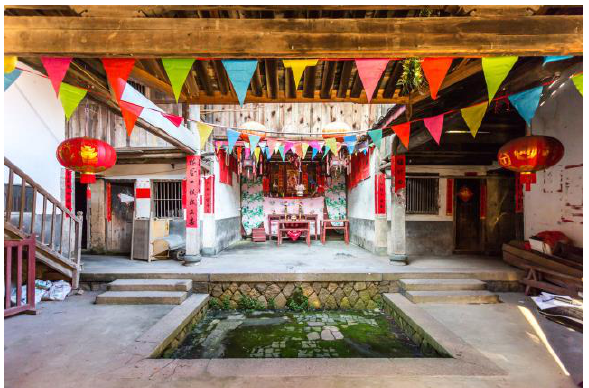
Figure 11. The impluvium and the skywell in front of the family altar. Photo by the first author (2018).